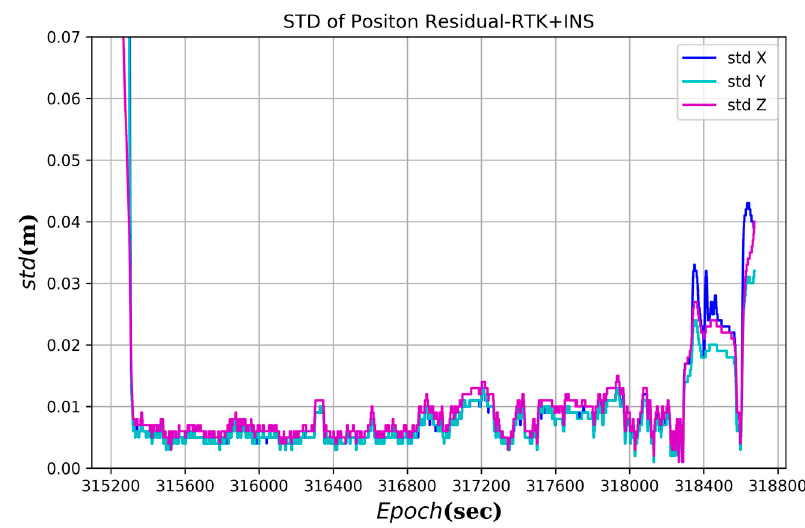
Figure 11. STD of Position 1[sigma].